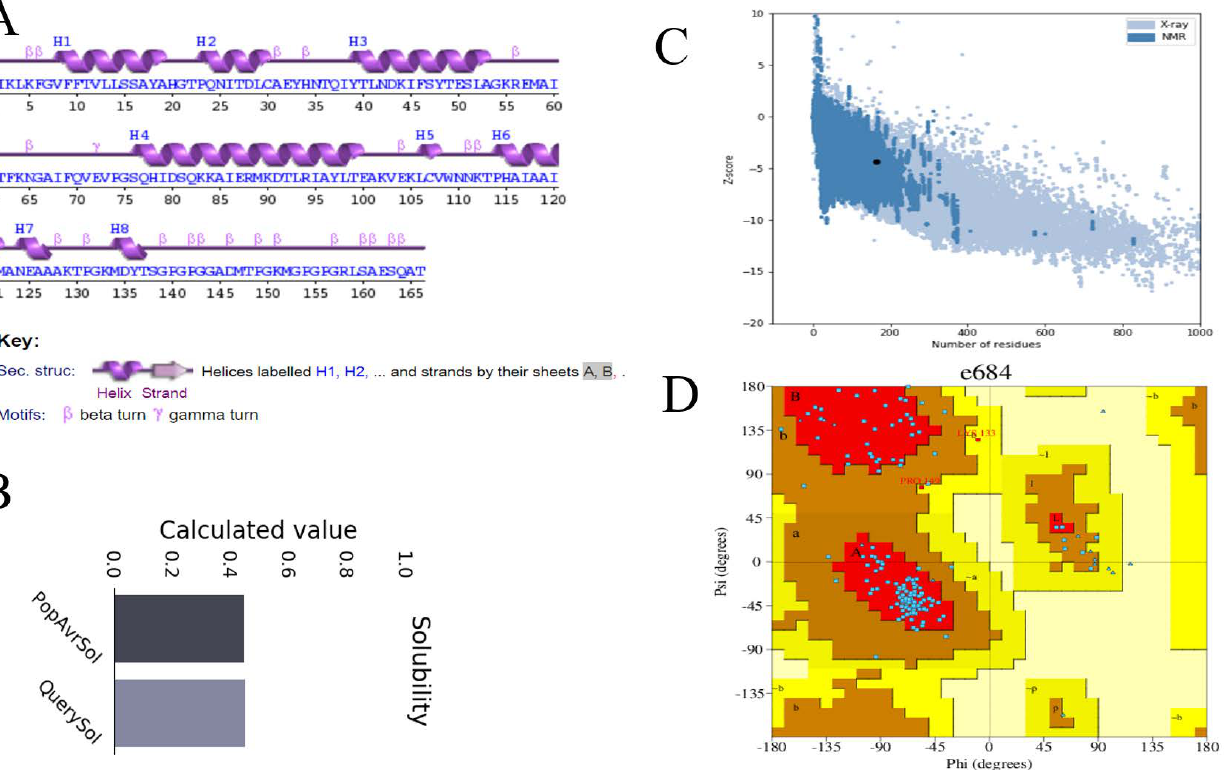
Figure 7. ( A ) Secondary structure, ( B ) computed solubility, ( C ) Z-score graph and ( D ) Ramachandran plot.